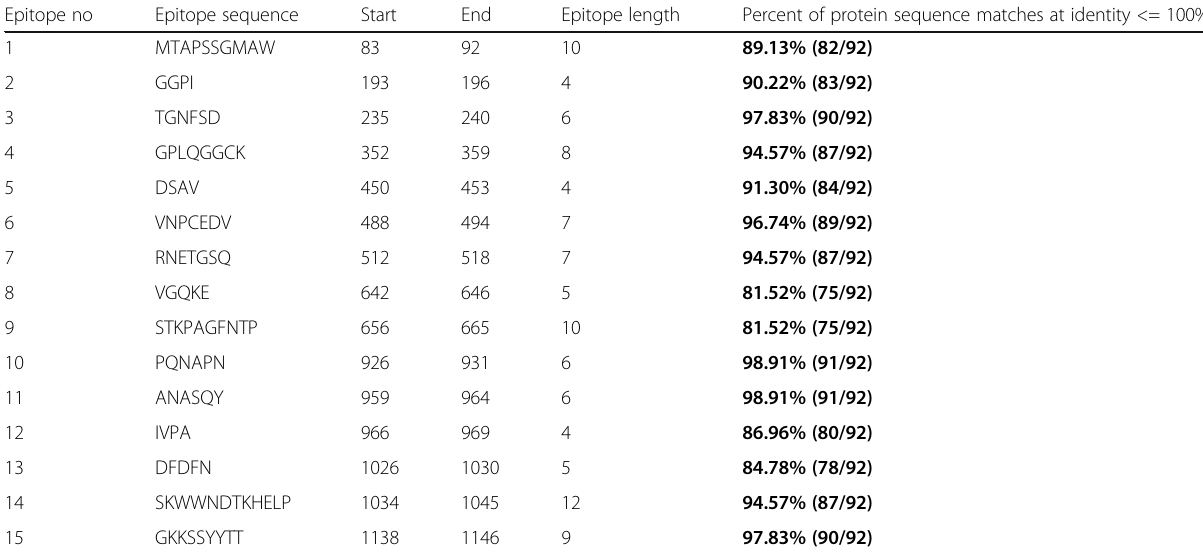
Table 3 Conservancy assessment of B cell linear epitopes